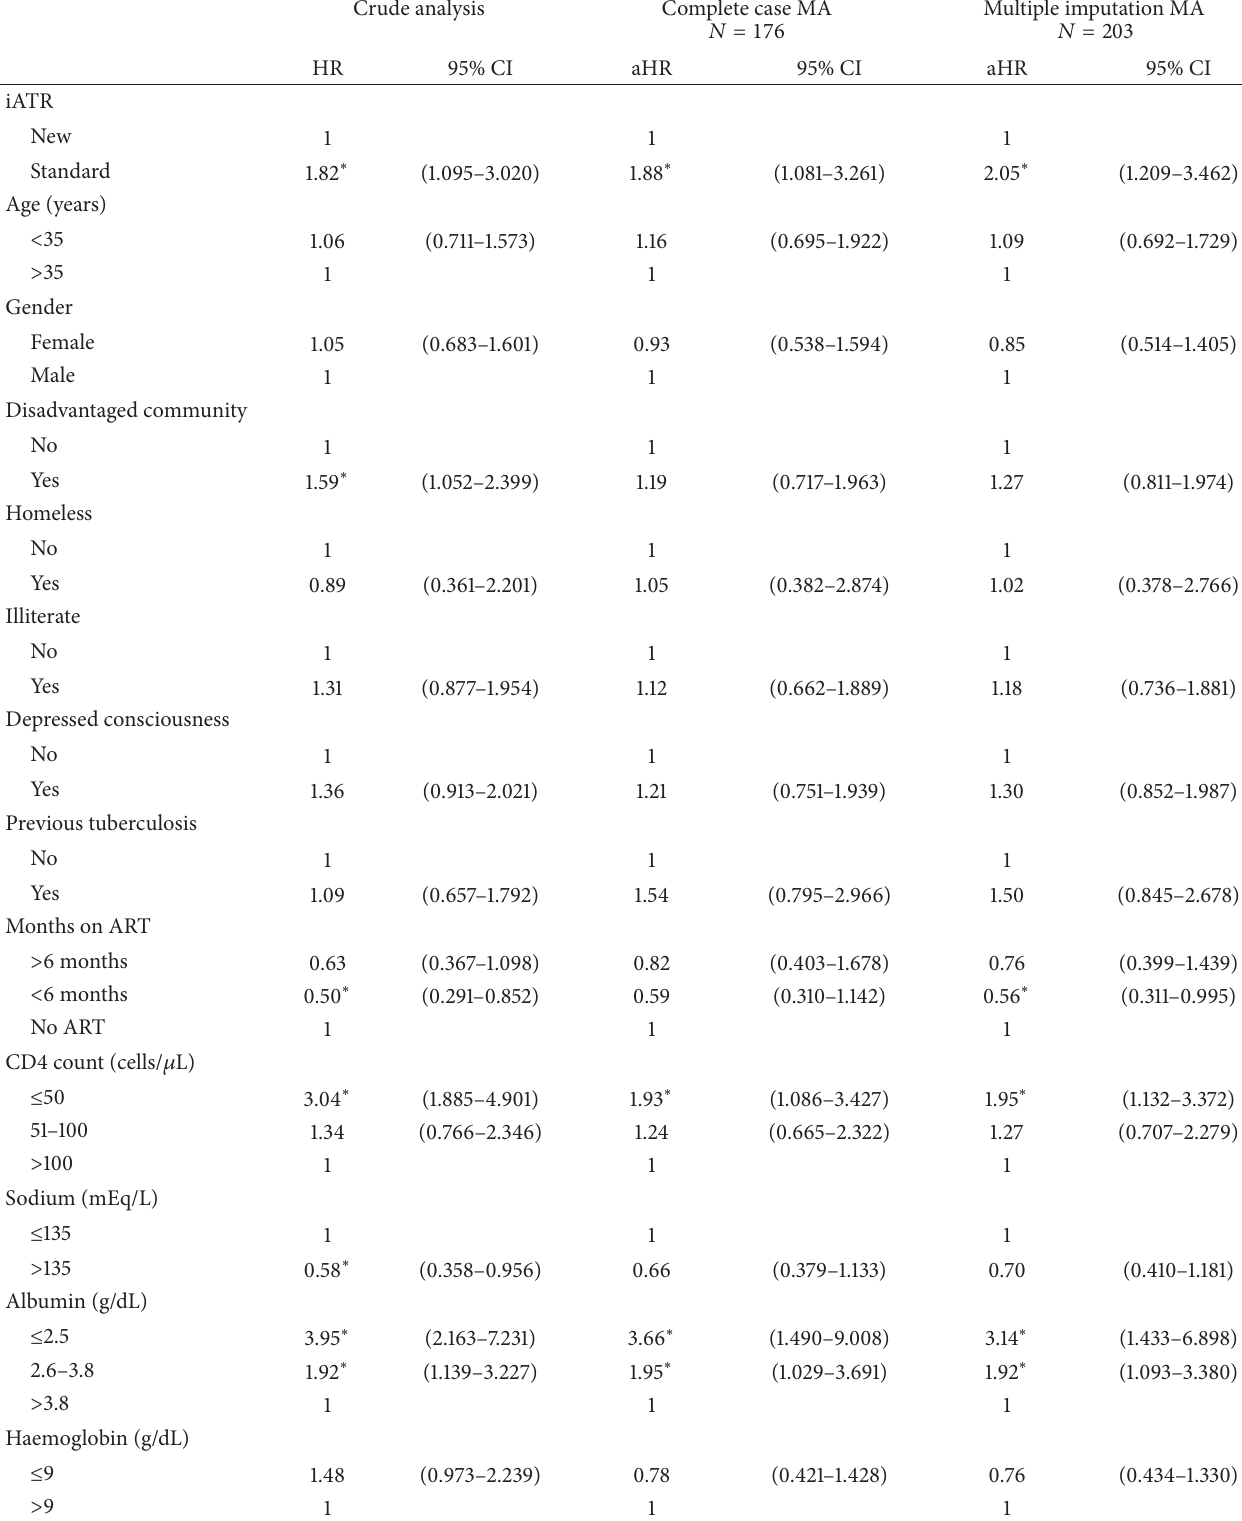
Table 2: Crude and multivariable Cox regression analyses of factors associated with mortality in HIV patients with tuberculous